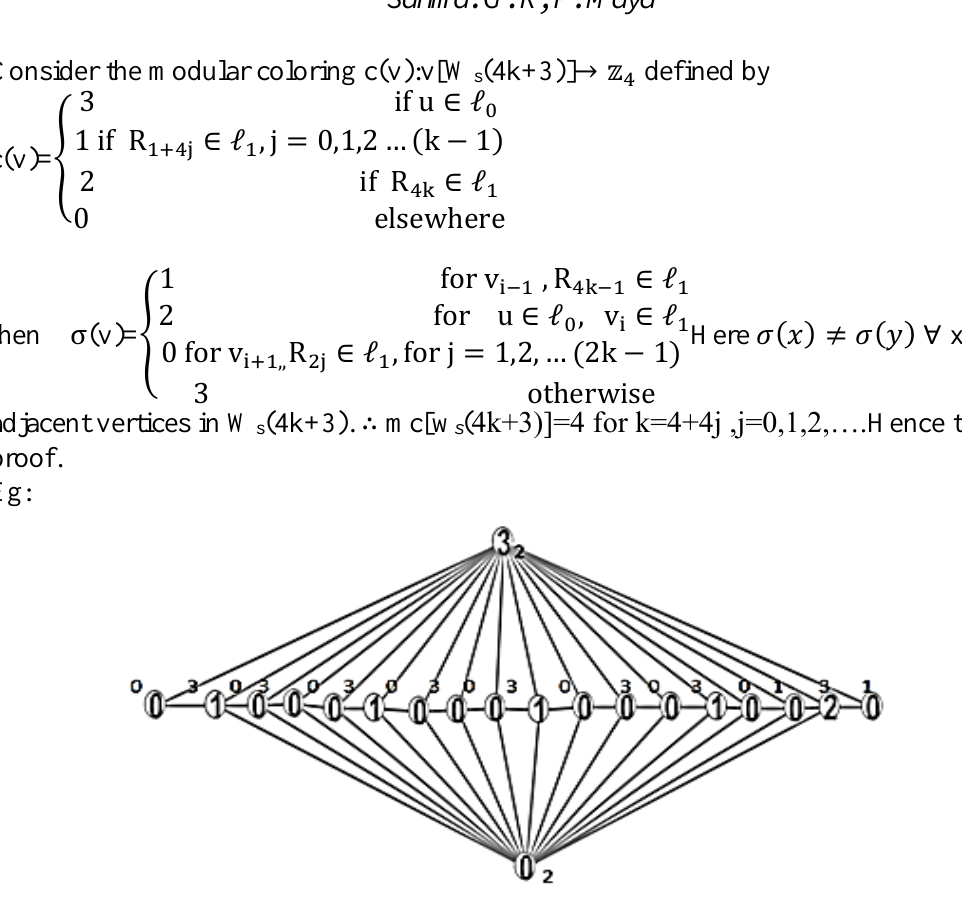
Figure 4 . Switching with modular coloring in